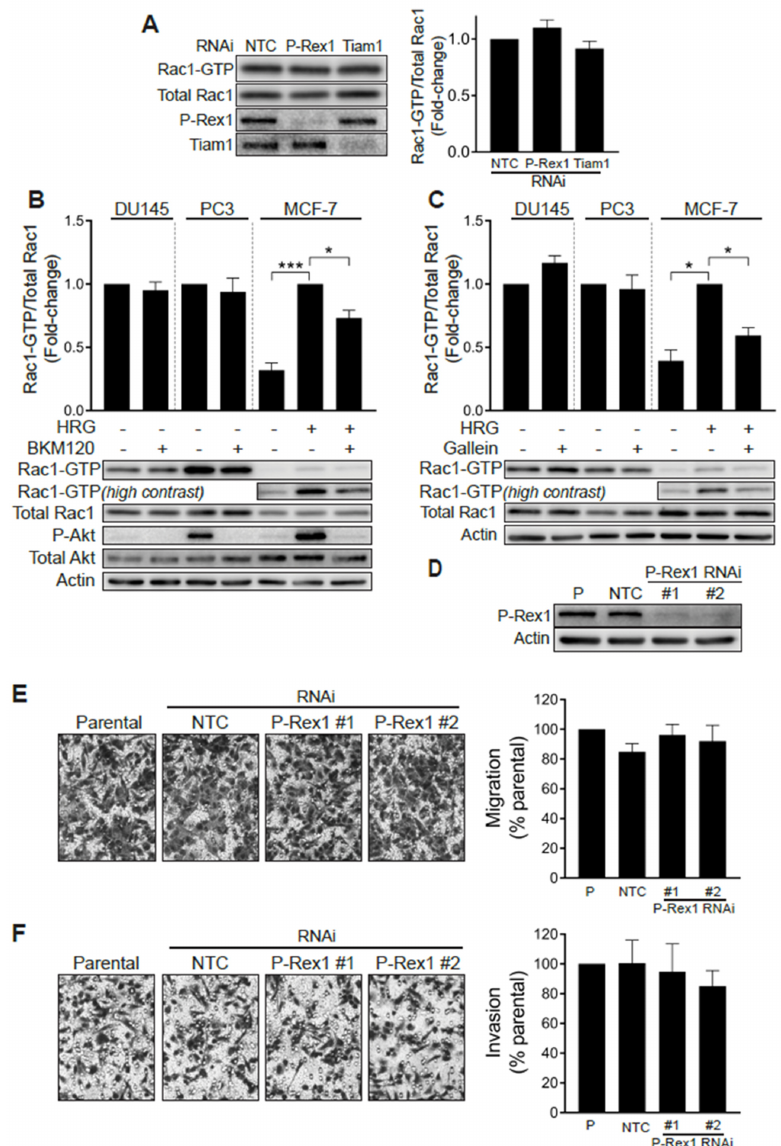
Figure 2. Rac1 hyperactivation in prostate cancer cells is independent of P-Rex1. ( A ) PC3 cells were transfected with P-Rex1, Tiam1 or non-target control ( NTC ) RNAi duplexes for 48 h, including a 24 h serum starvation prior to Rac1-GTP levels being determined using a PBD pull-down assay. Left panel , representative experiment. Right panel , densitometric analysis of Rac1-GTP levels normalized to total Rac1. Results, relative to NTC, are expressed as the mean ± S.E. ( n = 6). ( B ) E ff ect of the PI3K inhibitor BKM120 (2 µ M, 60 min) on basal Rac1-GTP levels in DU145 and PC3 prostate cells, and on HRG-stimulated (20 ng / mL, 5 min) MCF-7 breast cancer cells. ( C ) E ff ect of the G βγ inhibitor gallein (10 µ M, 30 min) on basal Rac1-GTP levels in DU145 and PC3 prostate cells, and on HRG-stimulated (20 ng / mL, 5 min) MCF-7 breast cancer cells. For B and C, lower panels are representative experiments. Densitometric analyses of Rac1-GTP levels normalized to total Rac1 are expressed as the mean ± S.E. ( n = 3–4) relative to non-treated cells (PC3 and DU145) or HRG-stimulated cells (MCF-7). ( D ) Representative Western blot of P-Rex1 expression in PC3 cells subjected to P-Rex1 silencing for 48 h using two di ff erent RNAi duplexes (#1 and #2). ( E ) PC3 migration assay using a Boyden chamber without Matrigel. ( F ) PC3 invasion assay using a Boyden chamber with Matrigel. For ( E , F ), representative experiments are shown ( right panels ). A quantitative analysis of migration and invasion is shown in the left panels . Results normalized to parental cells (P) are expressed as the mean ± S.E. ( n = 3). * p < 0.05; *** p <